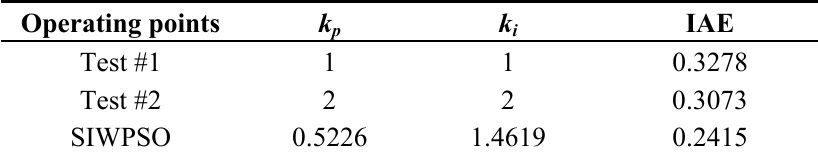
Figure 11. The stabilizing in the space for Equation